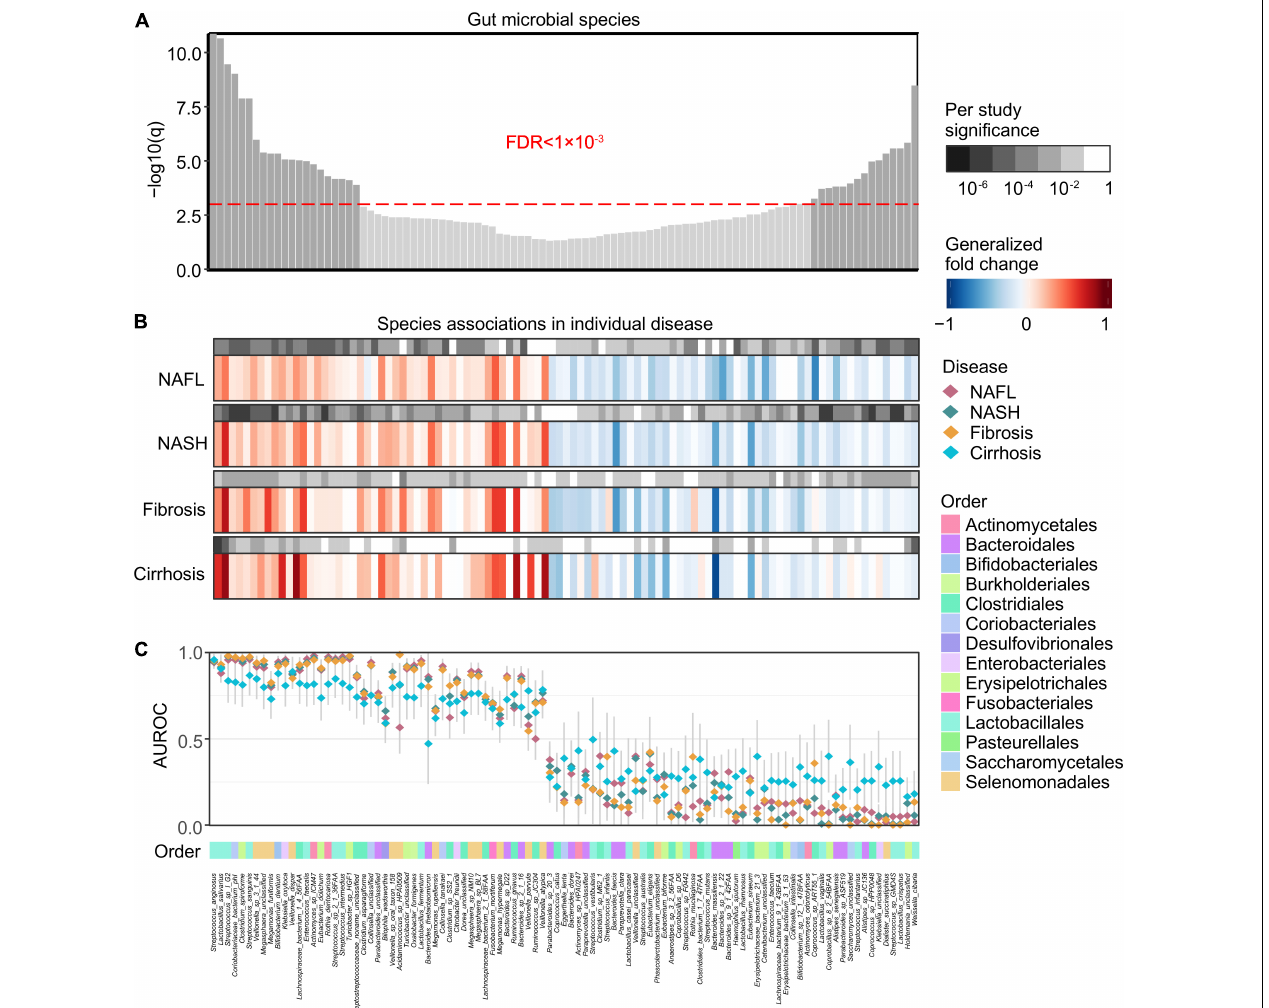
FIGURE 2 | Meta-analysis identifies a core set of gut microbes strongly associated with NAFLD. (A) Meta-analysis significance of gut microbial species derived from blocked Wilcoxon tests is given by the bar height (FDR = 0.05). Bars of a core of highly significant species (meta-analysis FDR = 1 × 10 - 3 ) were colored as dark gray. (B) Species-level significance, as calculated with a blocked two-sided Wilcoxon test (FDR P value), and the generalized fold change within individual stages are displayed as heatmaps in gray and in color, respectively. Species are ordered by meta-analysis significance and direction of change. NAFL, non-alcoholic fatty liver; NASH, non-alcoholic steatohepatitis. (C) Association strength is quantified by the AUROC across individual stages (color-coded diamonds), and the 95% confidence intervals are indicated by the gray lines. Order-level taxonomic information is color-coded above the species